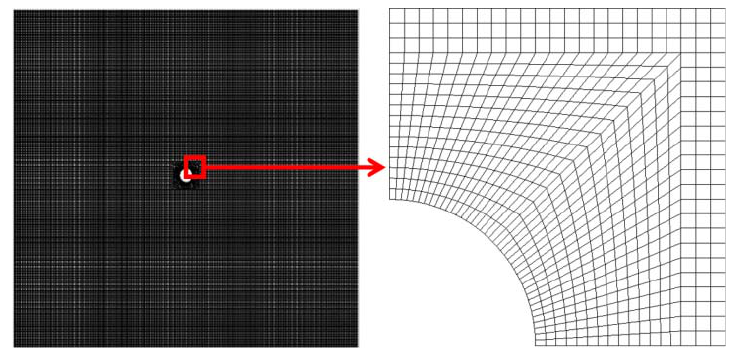
Figure 3. Mesh of the coal sample.